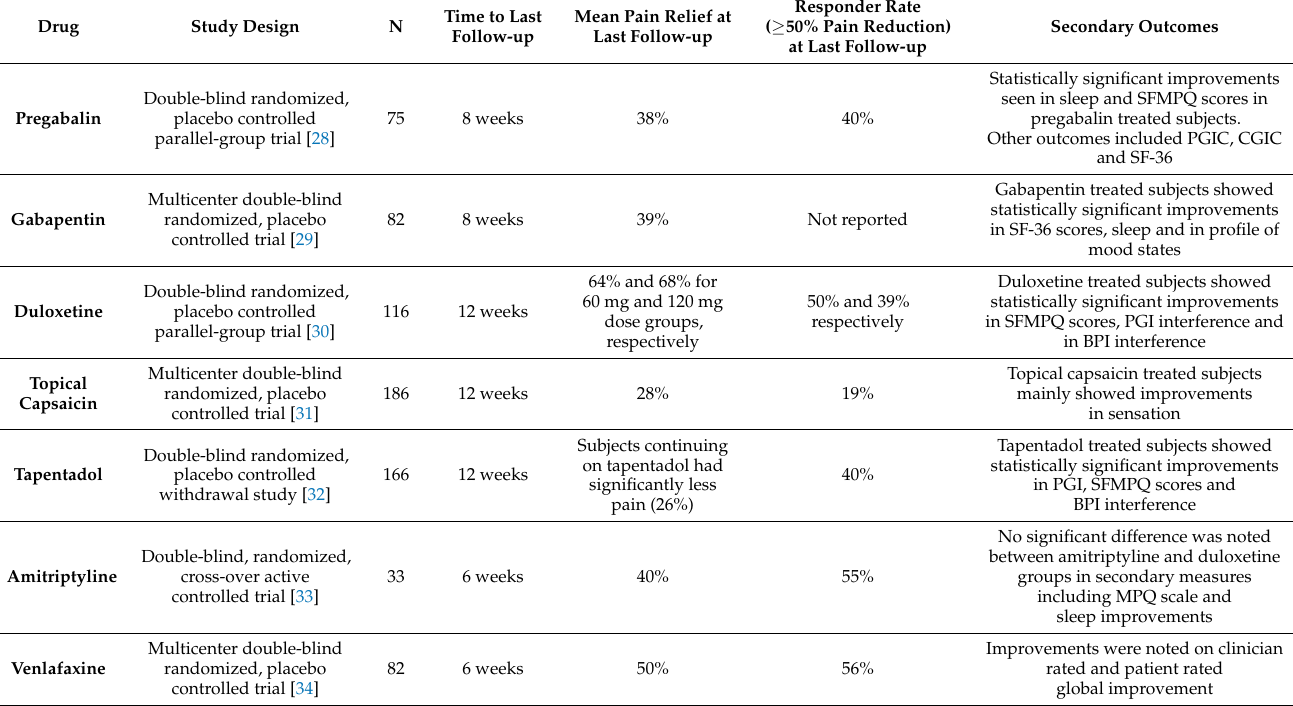
Table 3. Clinical trial data for pharmacotherapies of